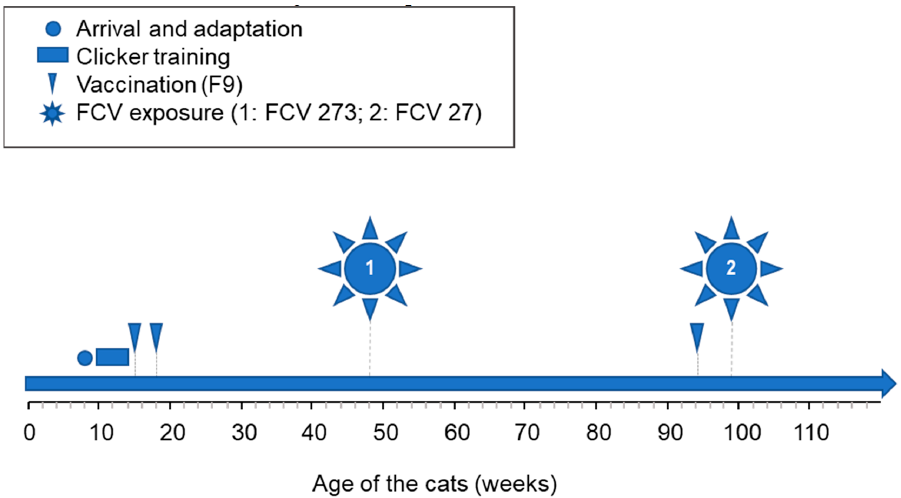
Figure 1. Study design. The cats were first adapted and trained for blood and sample collection. At the age of 15 and 18 weeks, the cats were vaccinated subcutaneously (FCV (feline calicivirus) F9 or placebo vaccine). Seven months later (age of 46 weeks), all cats were challenged using the FCV 273 virus. Eleven months later (94 weeks of age), all cats were revaccinated once (FCV F9 or placebo vaccine) prior to the second FCV challenge with FCV 27 at 99 weeks of age.